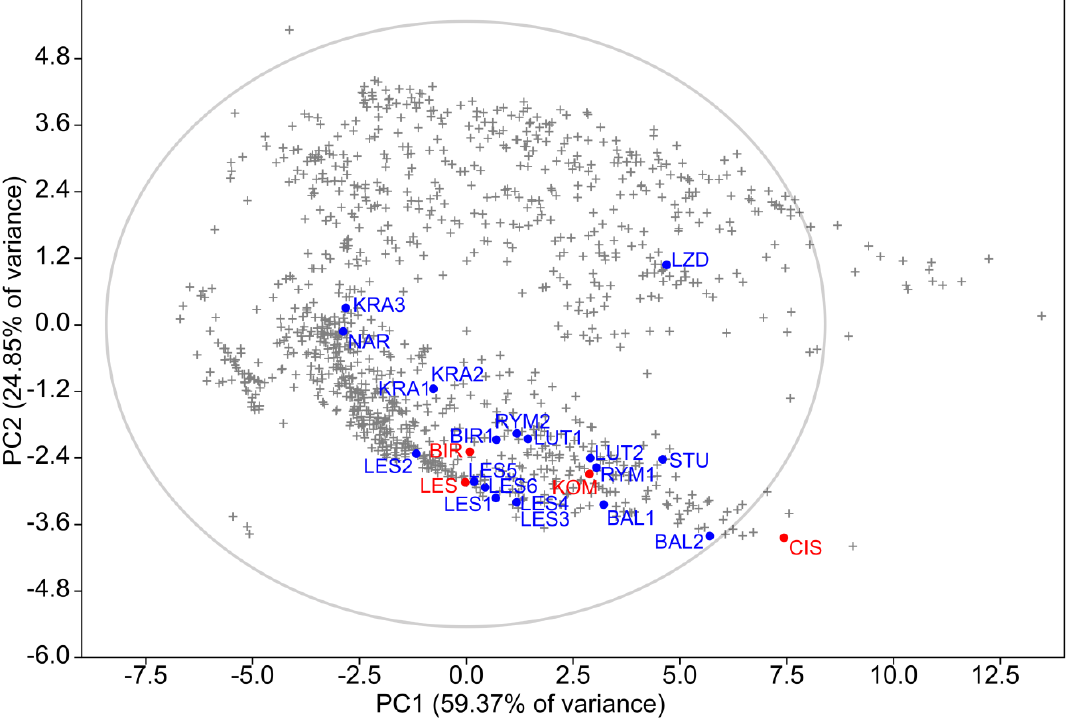
Figure 3. Climate-related variability between provenances and experimental sites. For the input data extraction of the altitude and 19 BIOCLIM indexes (http://worldclim.org/bioclim) for 1164 records, the included study sites and localities of silver fir from the native ranges of Poland were used. The